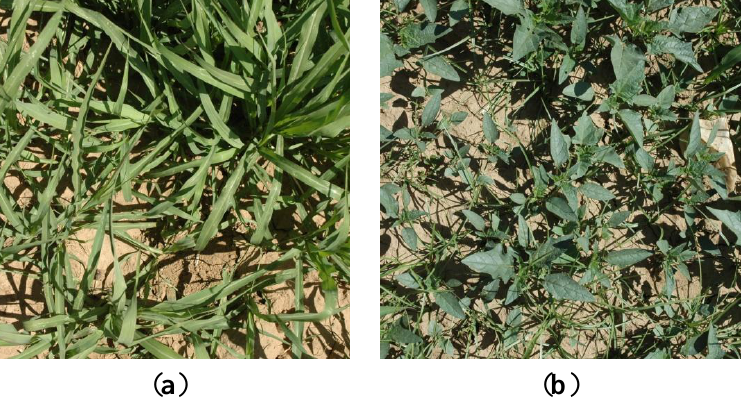
Figure 7. Images showing high levels of infestation of ( a ) monocot weeds and ( b ) a mixture of monocots and